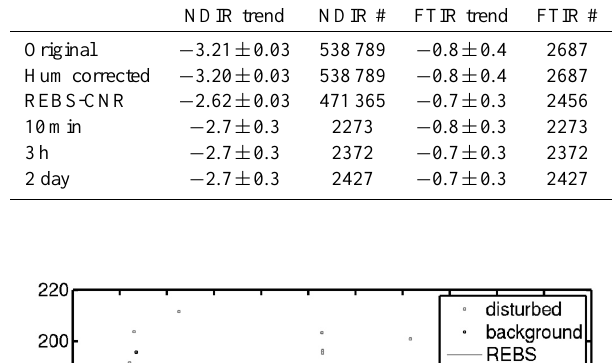
NDIR trend NDIR #